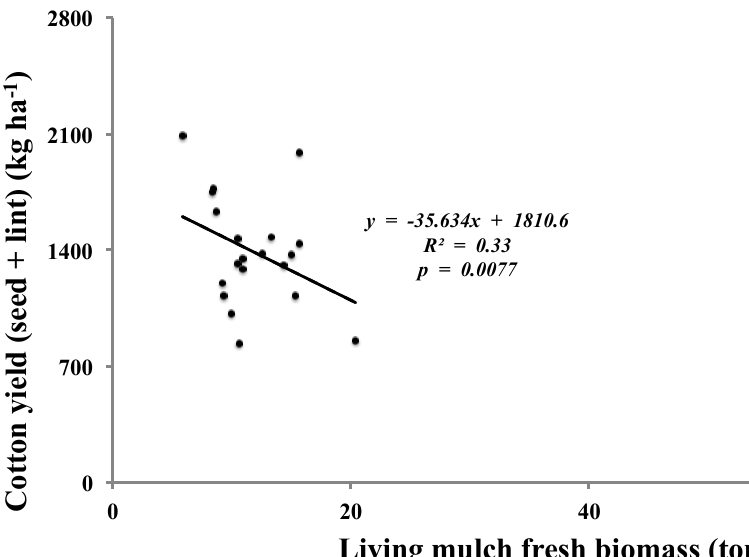
Figure 1. Relationship (linear regression, α = 0.05) between cotton yield and living mulch biomass during Year 1. All treatments and trial sites are represented.